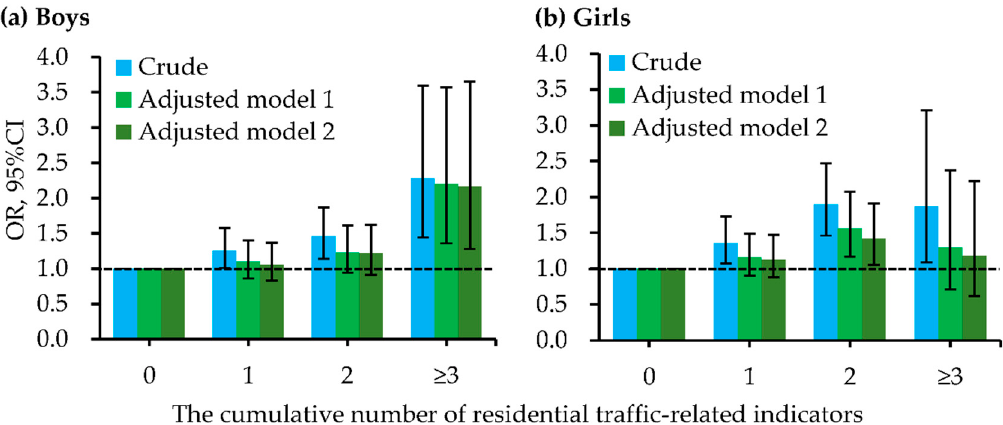
Figure 3. Dose-response relationships of the cumulative number of indictors for residential traffic within 200 m of the residence with odds of childhood pneumonia, stratified by the child’s sex. ( a ) Boys; ( b ) Girls. Adjusted factors in model 1 (multivariate logistic regression analyses) included age, residence-located area, family history of atopy, residence ownership, breastfeeding duration, household dampness-related exposures, household ETS, and household renovation during early lifetime. Adjusted factors in model 2 (two-level logistic regression analyses) included age, family history of atopy, residence ownership, breastfeeding duration, household dampness-related exposures, household ETS, and household renovation during early lifetime. The supplemental Table S5 presented the detailed data for odds ratios (ORs) and their 95% confidence intervals (CIs). The p -values for interaction in crude model, adjusted model 1, and adjusted model 2 were <0.001, 0.002, and 0.006,